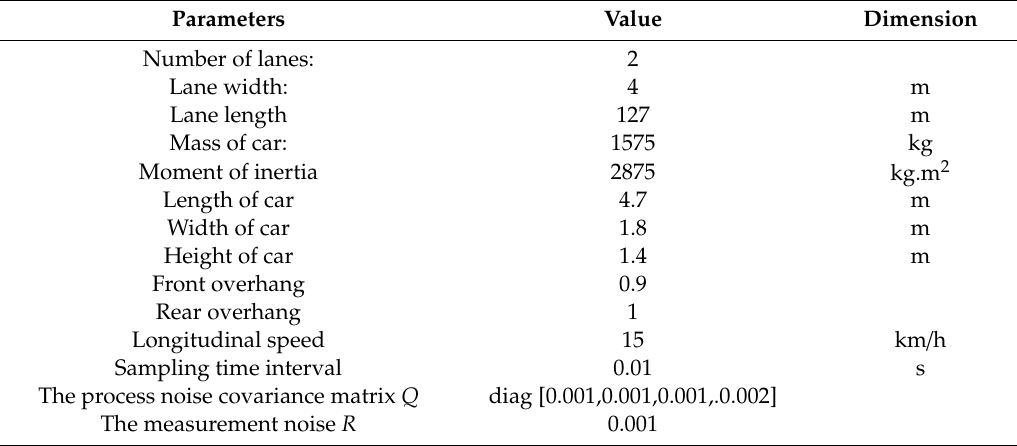
Table 1. The simulation parameters.